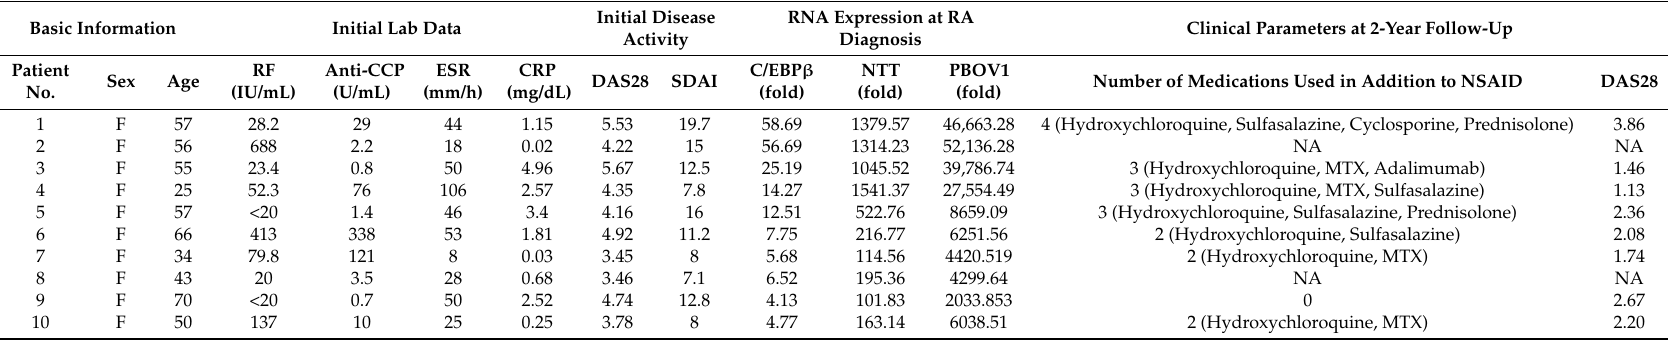
Table 1. Clinical characteristics of RA (rheumatoid arthritis) patients and their C/EBP β /NTT/PBOV1 expression levels in PBMCs (peripheral blood mononuclear cells). Basic